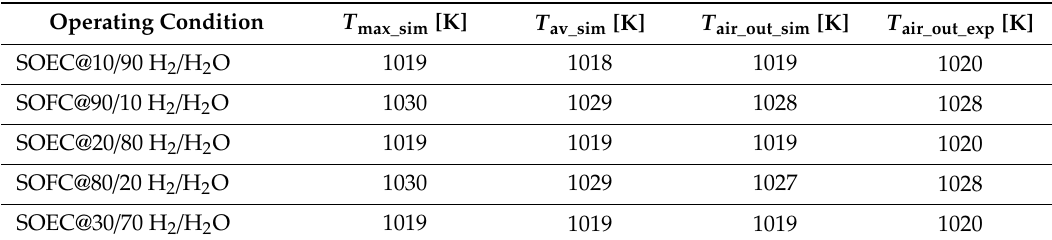
Table 6. Simulated and measured temperatures for short stack at 0.3 A cm − 2 and − 0.3 A cm − 2 in the SOFC and SOEC modes,